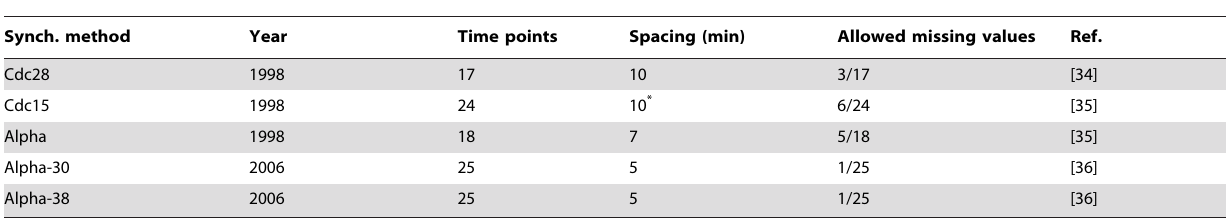
Table 2. Budding yeast cell-cycle microarray datasets.